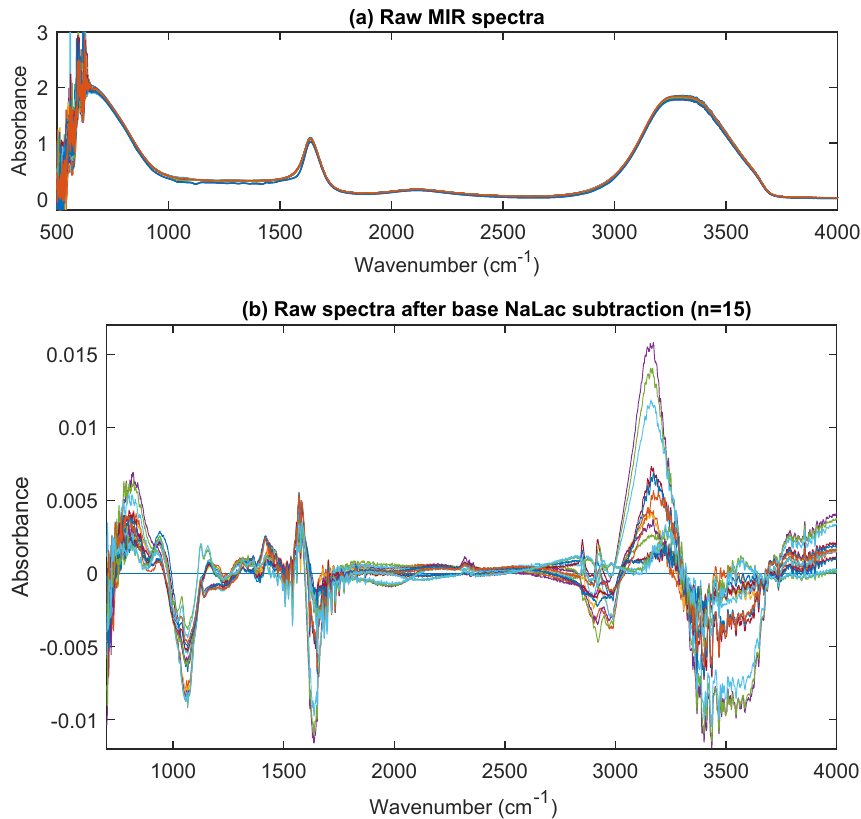
Figure 6. ( a ) Raw MIR spectra (500–4000 cm − 1 ) of PBS samples (concentration range: 0–20 mmol/L) ( b ) the raw spectra after noise removal and base lactate correction (n = 15). Several peaks were identified in the footprint region (700–1500 cm − 1